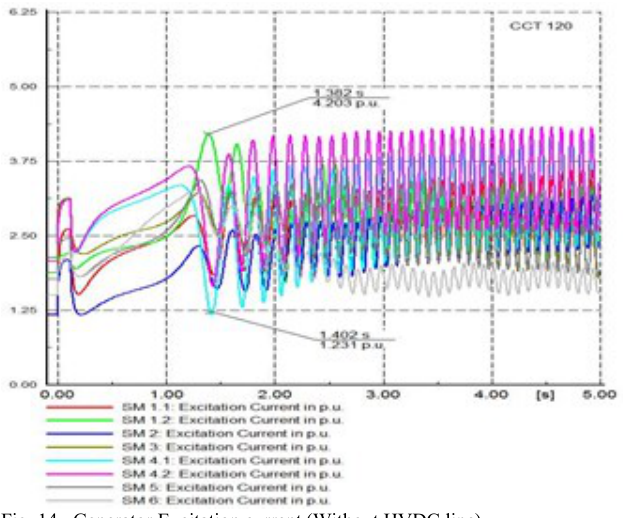
Fig. 14. Generator Excitation current (Without HVDC line) 2) Second scenario (With HVDC line).